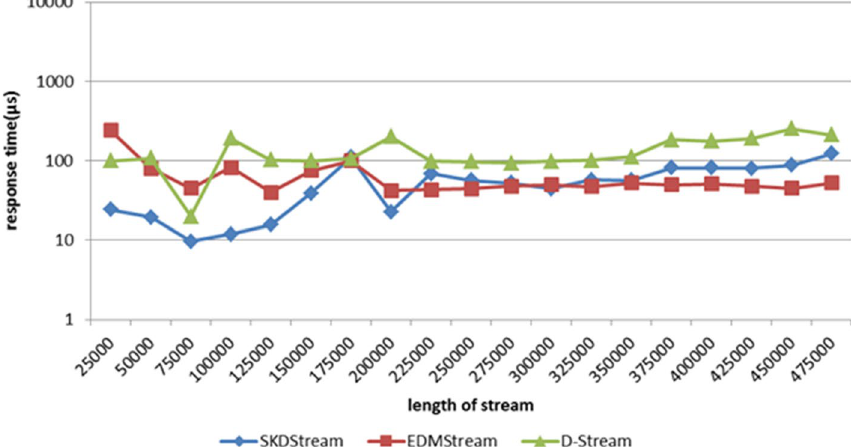
Fig. 15 Comparison of response time (KDDCUP99). In the figure 15, the blue, red and green fold described the response timeof SKDStream, EDMStream and D‑Stream respectively in the